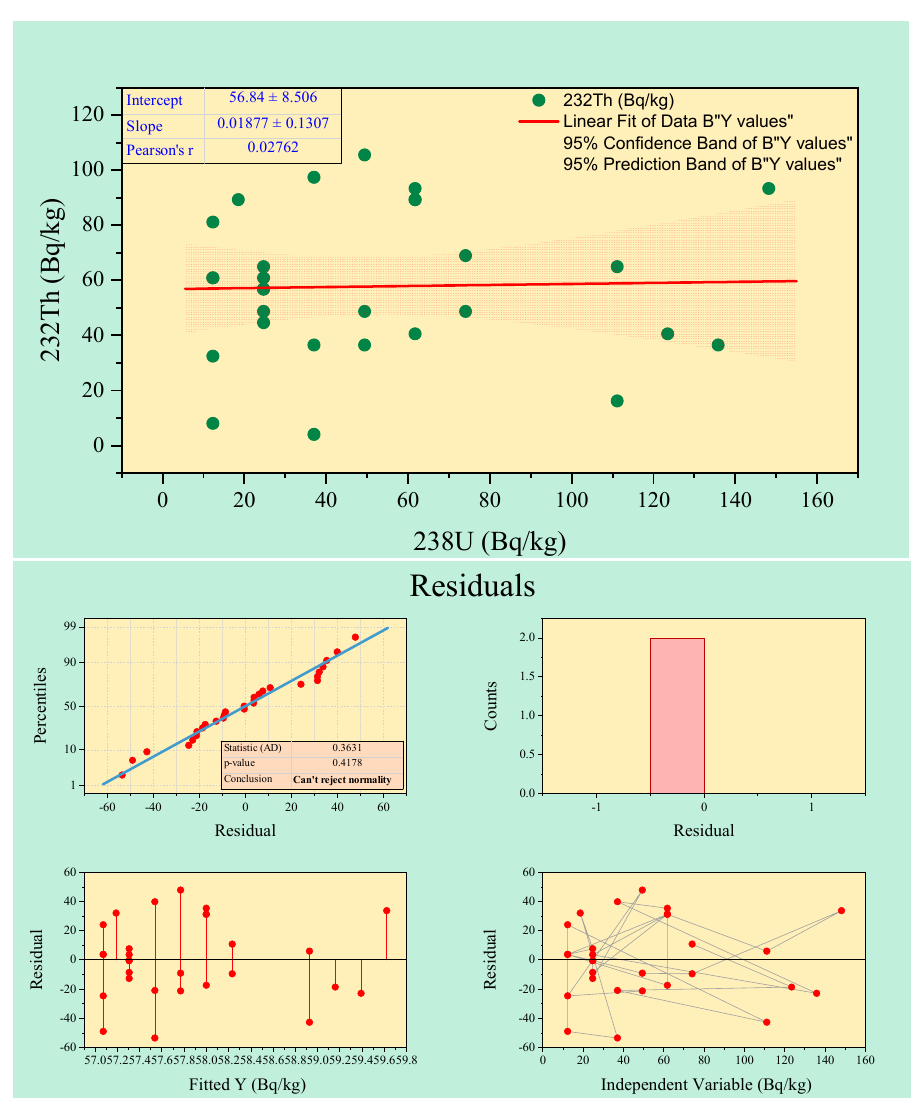
Figure 5. Linear regression LR with residuals analysis of 232 Th to 238 U of granitic rocks samples. The sampling site-specific variations of 238 U, 226 Ra, 232 Th, and 40 K radioactivity con- centrations (Bq kg − 1 ) with minimum, mean and maximum values for the studied samples shown in Figure 6. G2 sample has the highest values of 238 U (148.20 Bq kg − 1 ) and 226 Ra (88.80 Bq kg − 1 ), while the BA3 and R2 samples have the highest values of 232 Th (105.56, Bq/kg) and 40 K (1483.62 Bq kg − 1 ), respectively.